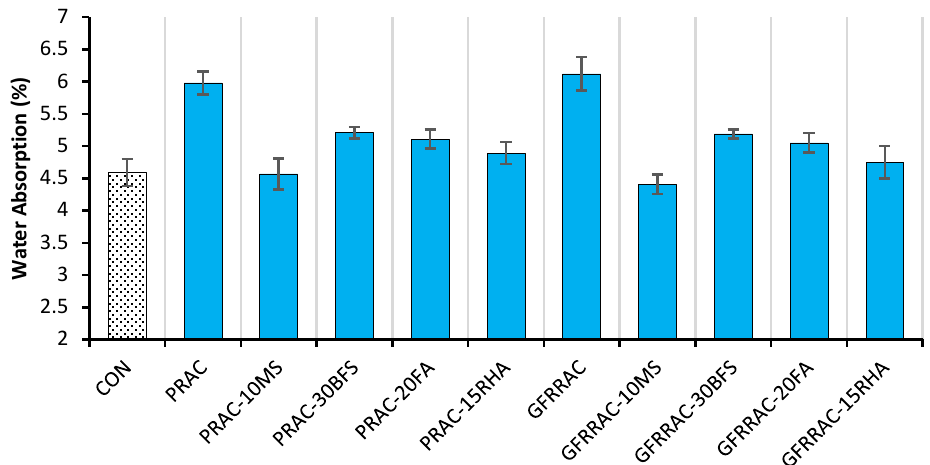
Figure 18. Water absorption capacity of RAC with different mineral admixtures and glass fibers.